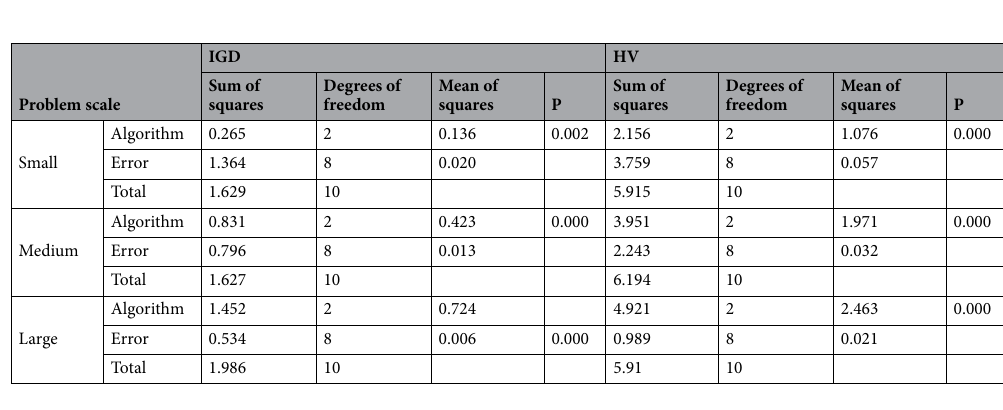
Table 8. ANOVA table for IGD and HV at different problem scales.